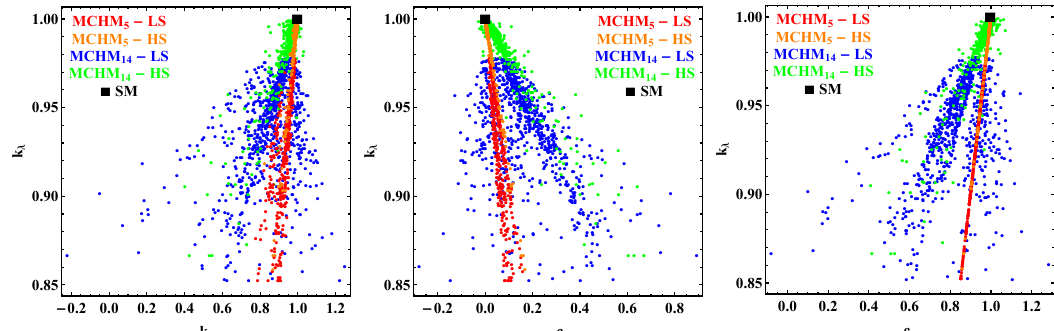
Figure 21 . Values of some selected EFT parameters in the low and high scale scans of the MCHM 5 and the MCHM 14 parameter spaces. The SM parameters position is represented by the black